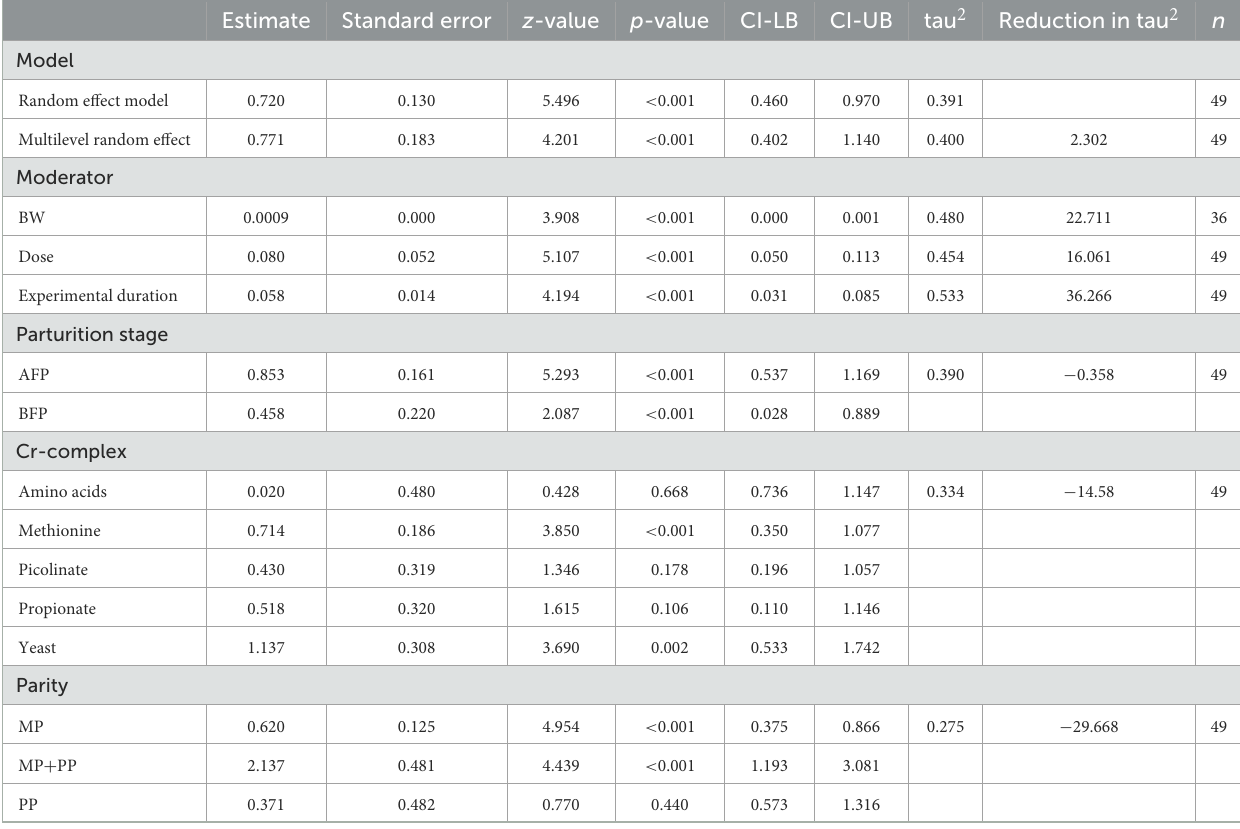
TABLE 1 A summary of statistical models and moderators for the dry matter intake